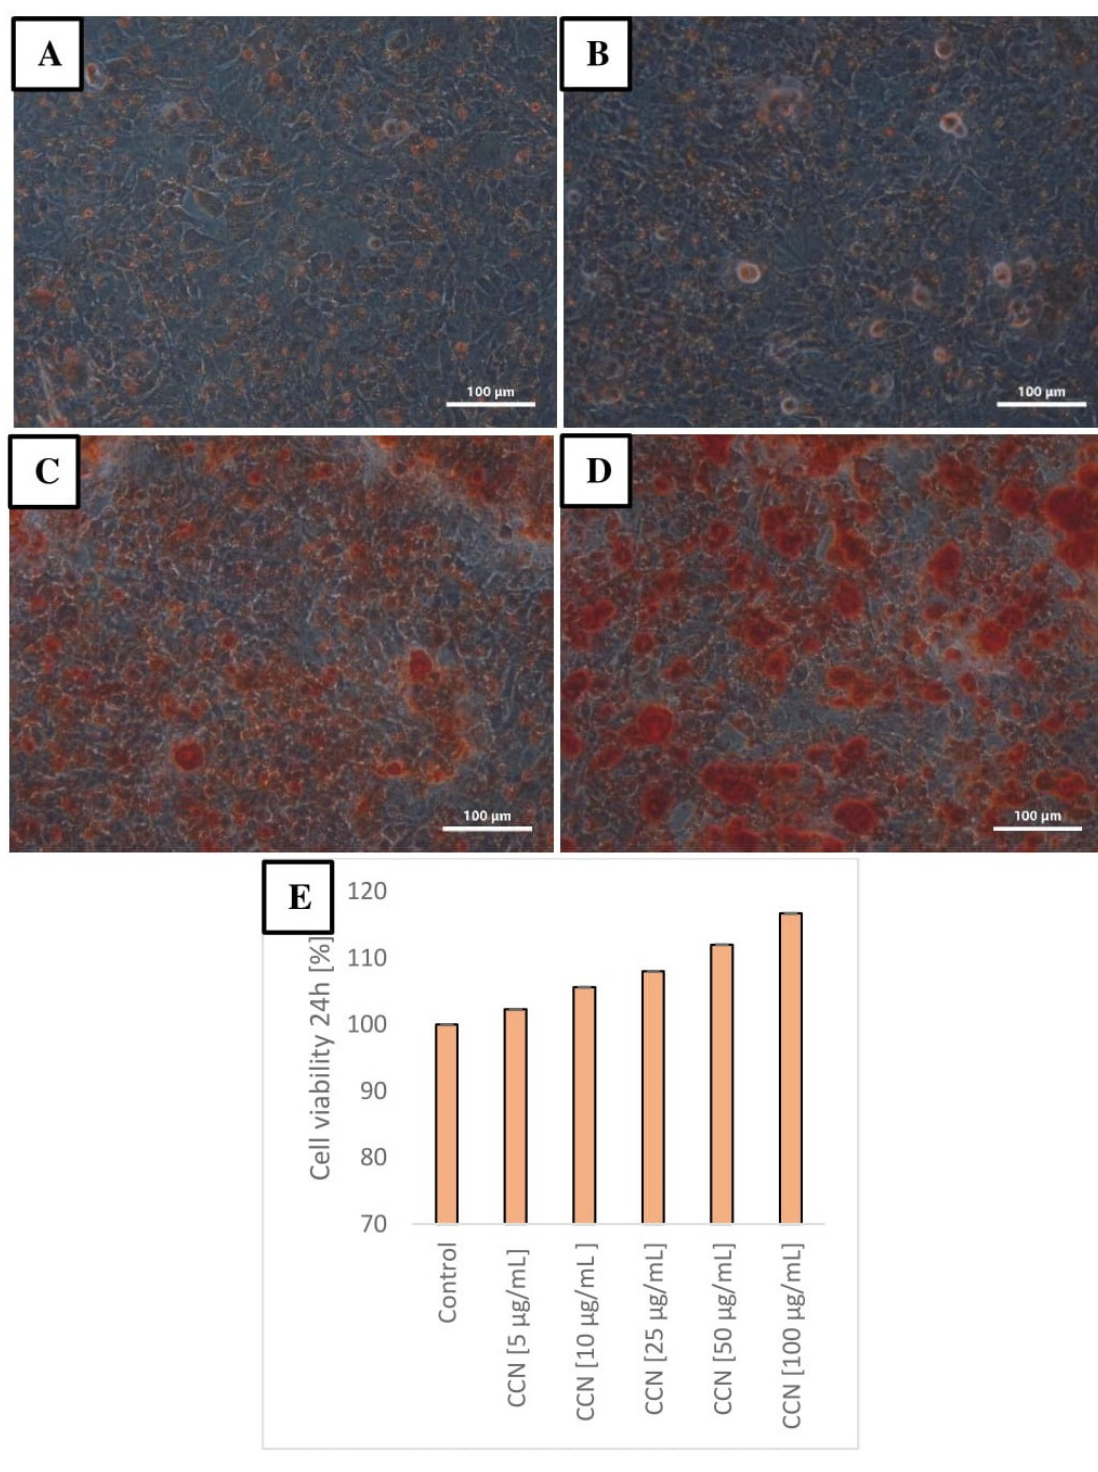
Figure 2. Alizarin red staining for mineralization. The calcified nodules appeared bright red color (original magnification × 100). Cells in control group, without CNN ( A ). Cells incubated with CCN at 5 µ g/mL ( B ). Cells incubated with CCN at 25 µ g/mL ( C ). Cells incubated with CNN at 100 µ g/mL ( D ). Cell viability in groups with increasing CCN concentration determined by the XTT assay after 24 h of incubation ( E ). The error lines represent standard error of mean.